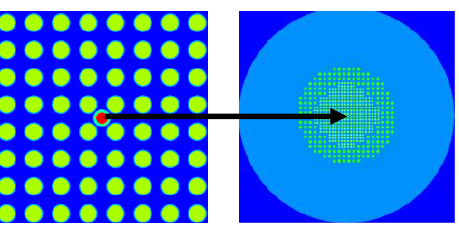
Figure 3. TRIPOLI-4 modeling of the reactivity modulator in the center of reduced scale fuel lattice (left) and in the full core of CROCUS